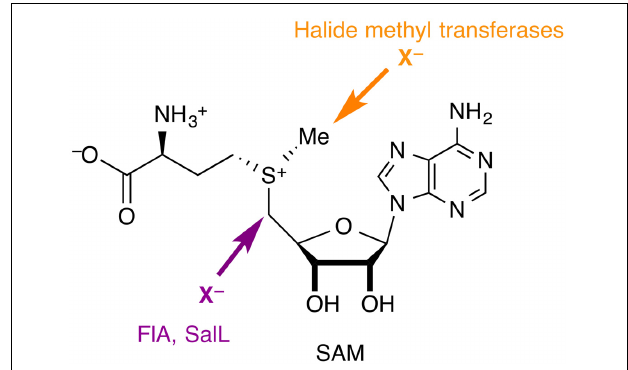
FIGURE 4 | Nucleophilic halogenases catalyze the attack of halide anions as nucleophiles on SAM. The fluorinase FlA and the chlorinase SalL produce halogenated adenosines, whereas halide methyl transferases produce